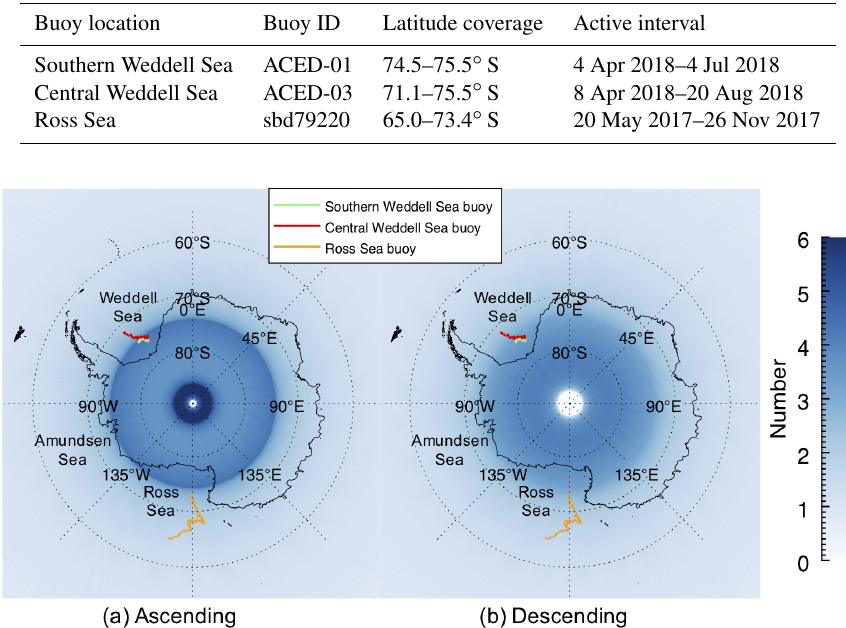
Table 1. Buoy deployment information.